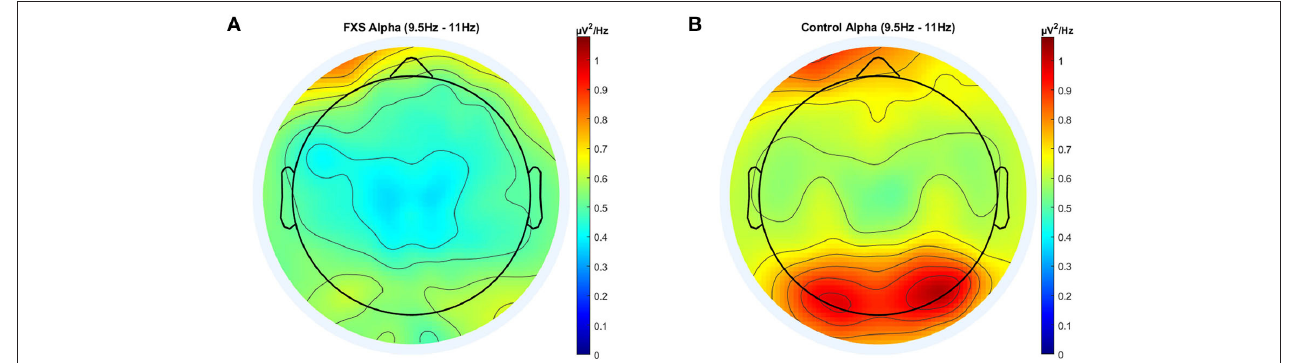
FIGURE 3 | Topographic representation of average power spectral density in the FXS (A) and control (B) group for the alpha band (9.5–11Hz).